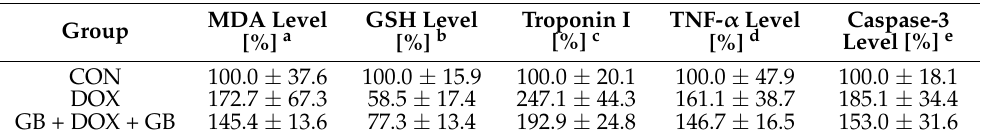
Table 8. Changes of cardiac biomarkers due to co-administration of Ginkgo biloba (GB) with doxoru- bicin in rats [69].